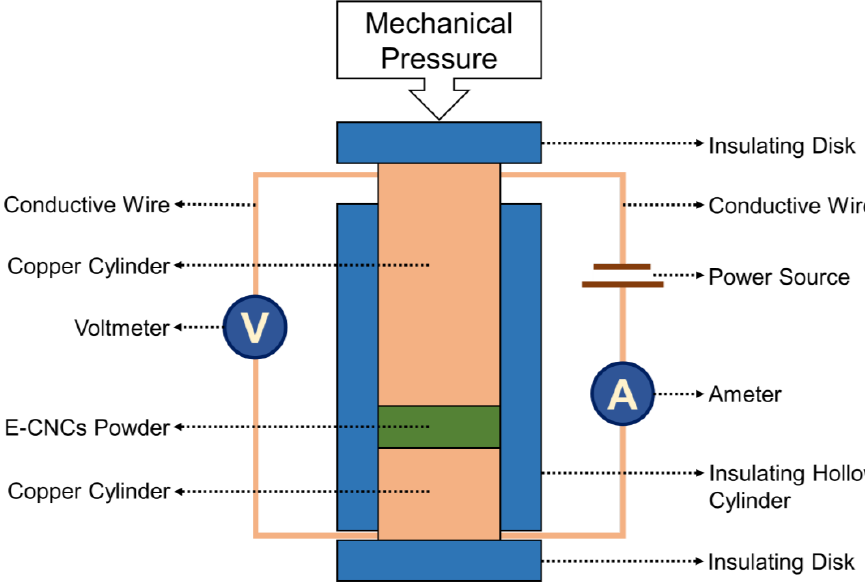
Figure 2. The setup used to measure the electrical conductivity of the E-CNCs powder, which is based on the four-point